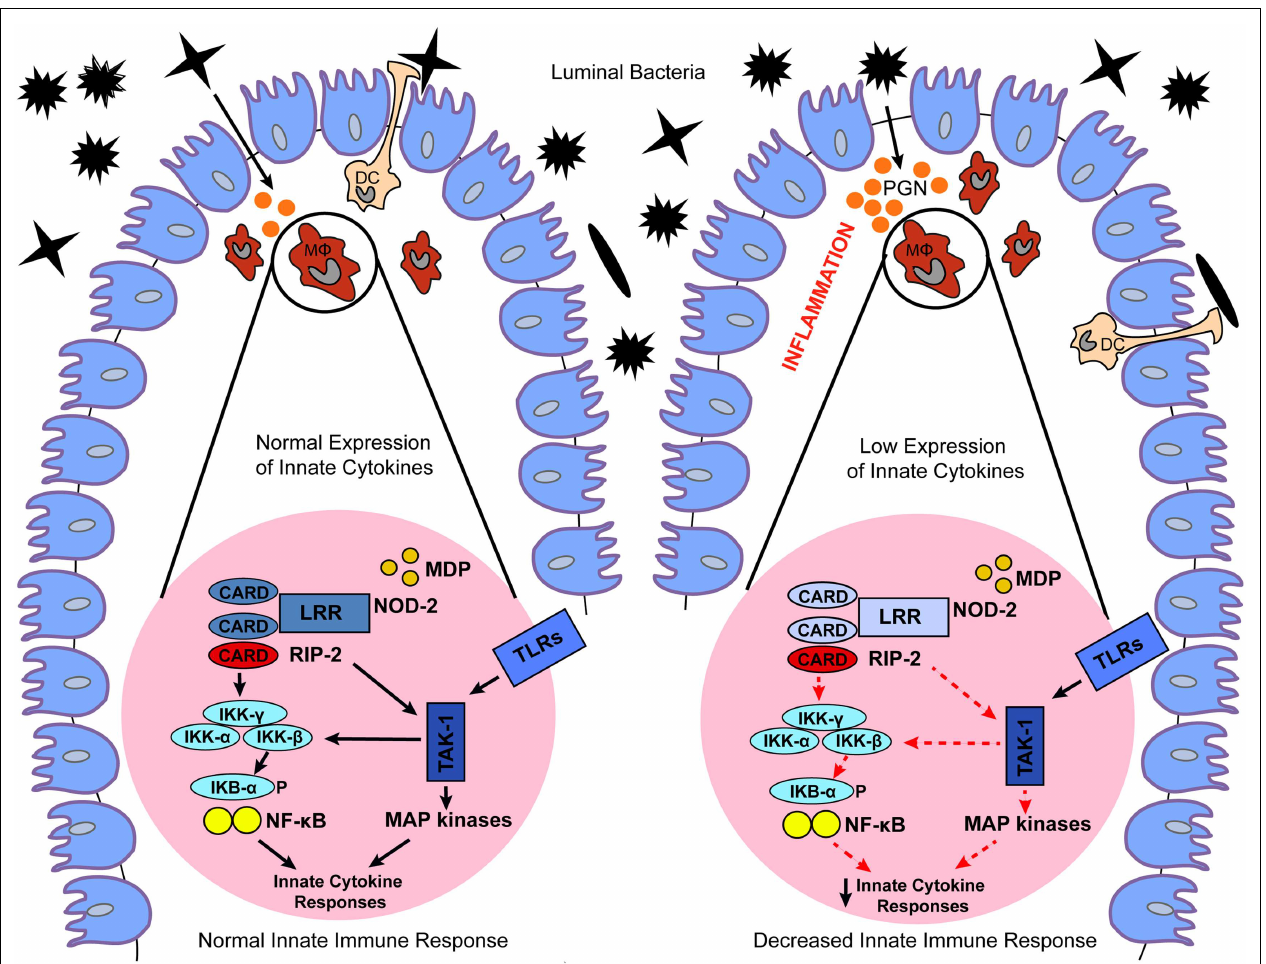
activation of I κ B kinase (IKK) complex, and I κ B α phosphorylation and degradation.The NOD2:RIP2 complex also leads to activation of MAP kinases.This results in expression of innate cytokines, which promote normal bacterial clearance and maintain intestinal homeostasis. In contrast, genetic or functional defects in NOD2 cause a loss-of-function on downstream NOD2 signaling, which ultimately leads to decreased expression of innate cytokines. Decreased NOD2 function may result in a failure to respond to bacteria, facilitating their invasion and interaction with the gut mucosal immune system, which culminates in chronic intestinal inflammation typical of